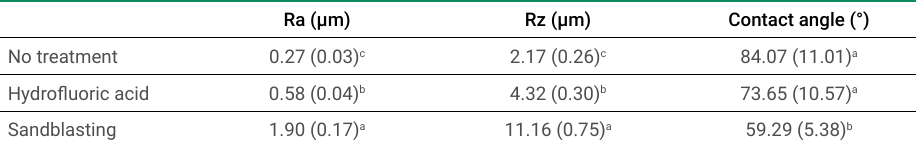
Table 3. Means (standard deviations) of average roughness (Ra), ten-point-mean roughness (Rz), and contact angle of the ceramic after the surface treatments. Ra (µm) Rz (µm) Contact angle (°) No